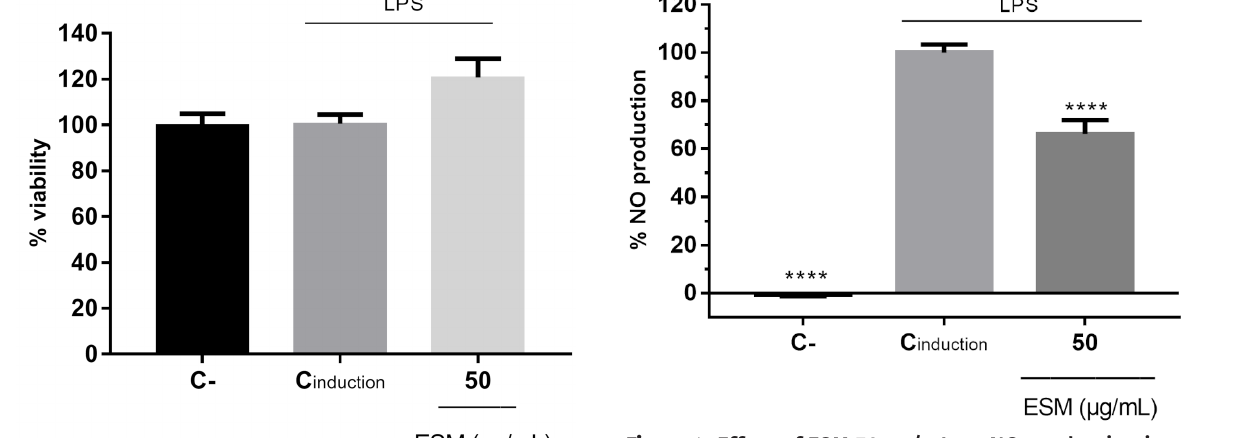
Figure 4. Effect of ESM 50 μg/mL on NO production in an in vitro model of LPS-induced neuroinflammation. Murine BV-2 cells microglial cell line was used. - induction Induction control (C - DMEM with 2% FBS induction and LPS) and negative control (C- - DMEM with 2% FBS) were used. The test was performed in five independent experiments, each in triplicate. Results were expressed in inhibition percentage compared to the induction control (C ). The mean ± S.E.M. induction was used. Bars with **** are extremely different ( p < 0.0001).